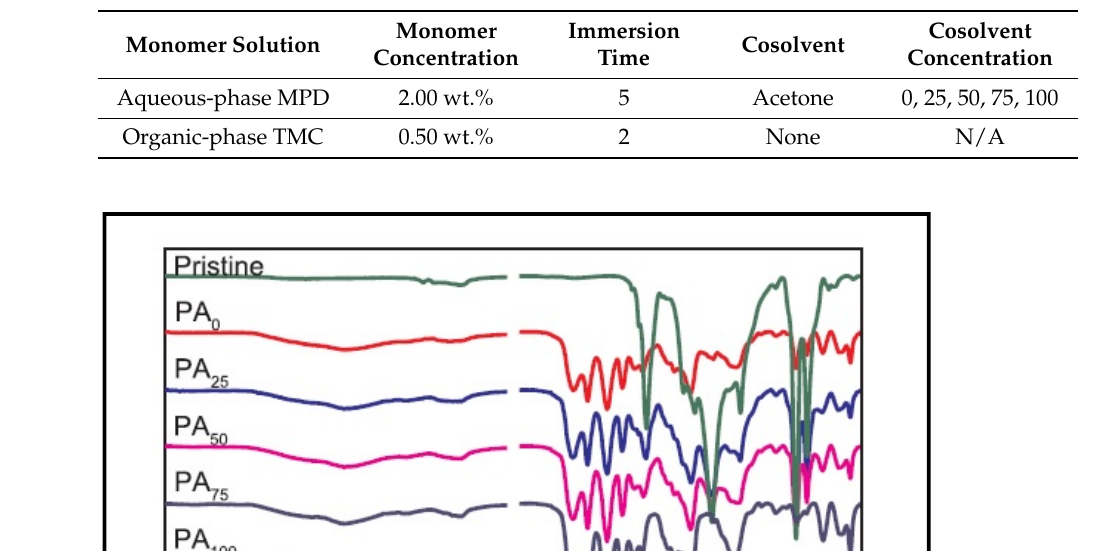
Table 5. Summary of interfacial polymerization conditions.